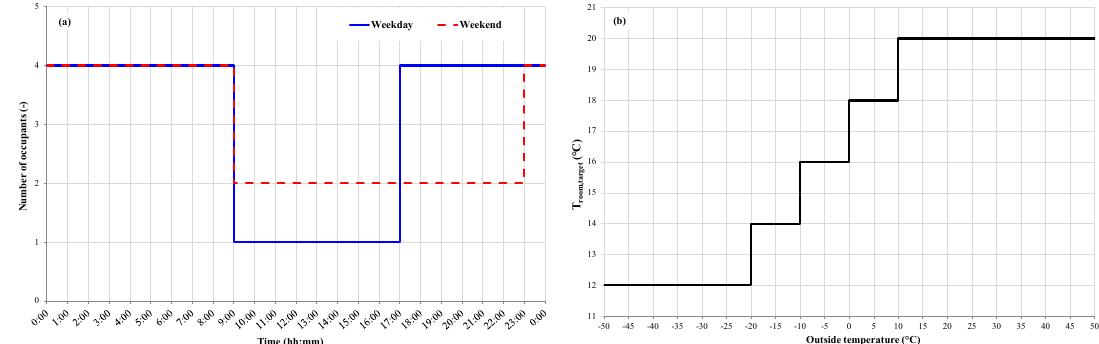
Figure 4. The daily profiles of the number of occupants as a function of the time ( a ) and the target room temperature as a function of the outside temperature ( b ).